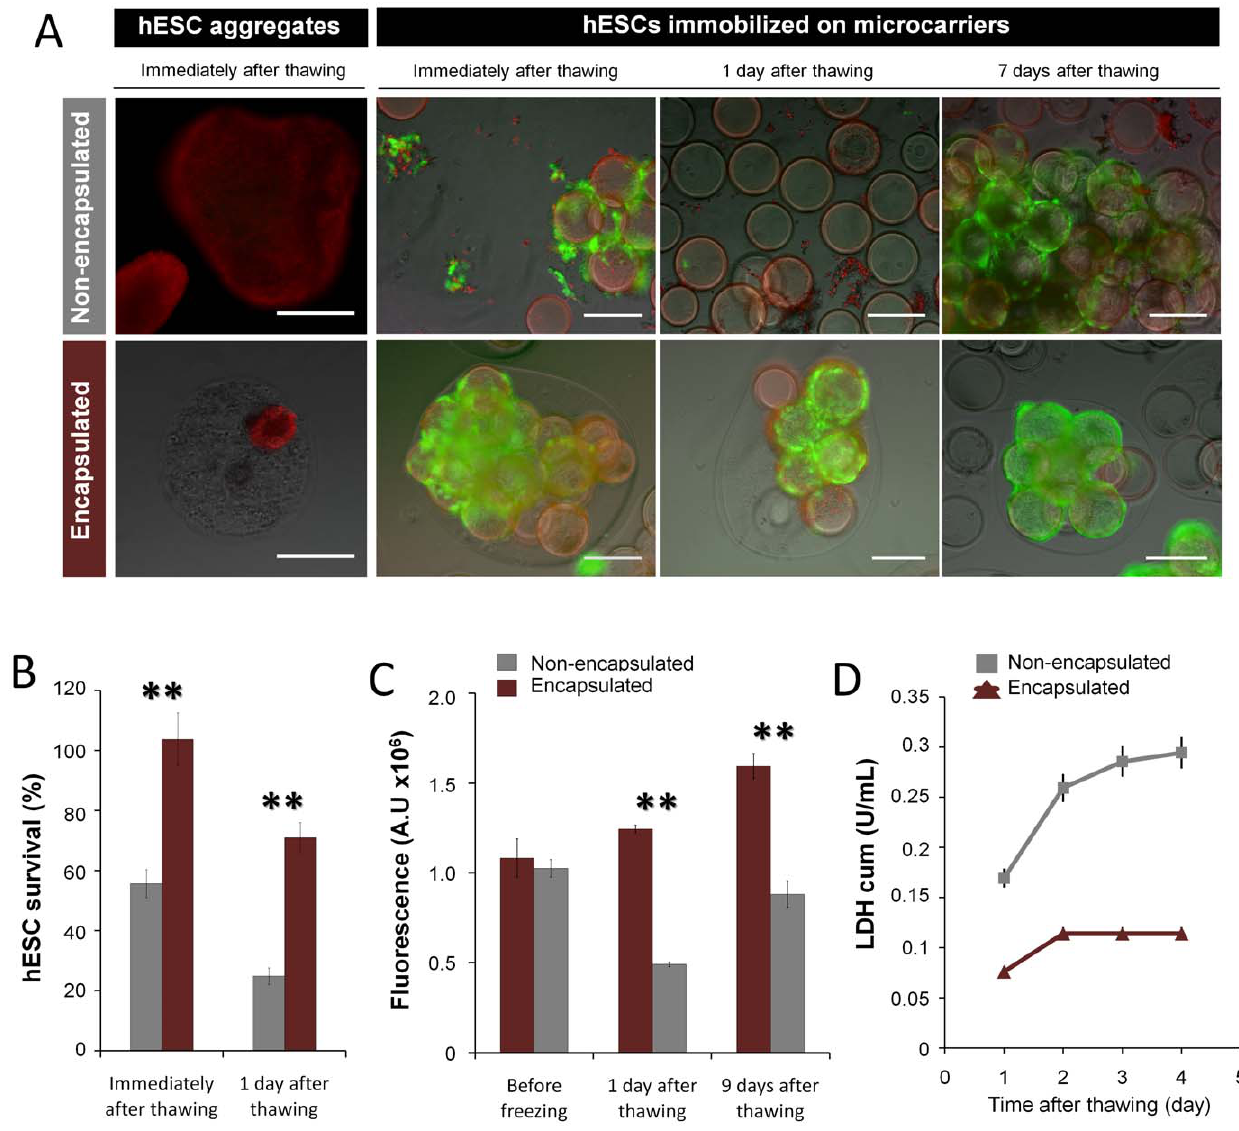
Figure 4. Post-thawing survival of non-encapsulated and encapsulated hESCs. Non-encapsulated and encapsulated hESCs were cryopreserved as aggregates or immobilized on microcarrier using a slow freeze rate method. ( A ) Phase contrast and fluorescence images of cryopreserved hESC immediately, 1, 3 and 7 days after thawing. Viability analysis of hESCs stained with fluoresceinediacetate (FDA-live cells, green) and propidium iodide (PI- dead cells, red). Scale bar: 200 m m. ( B–D ) Post-thawing characterization of non-encapsulated (grey) and encapsulated (purple) hESCs immobilized on microcarriers. ( B ) Percentage of cell survival immediately and one day after thawing. Error bars denote SD of 3 measurements. ( C ) Metabolic activity measured by alamarBlue test before cryopreservation and 1 and 9 days after thawing. Error bars denote SD of 4 measurements. ** indicates significant difference (P , 0.05) in metabolic activity by one-way ANOVA. ( D ) Cumulative values of specific rates of LDH release of cryopreserved hESCs after thawing. Error bars denote SD of 3 measurements.